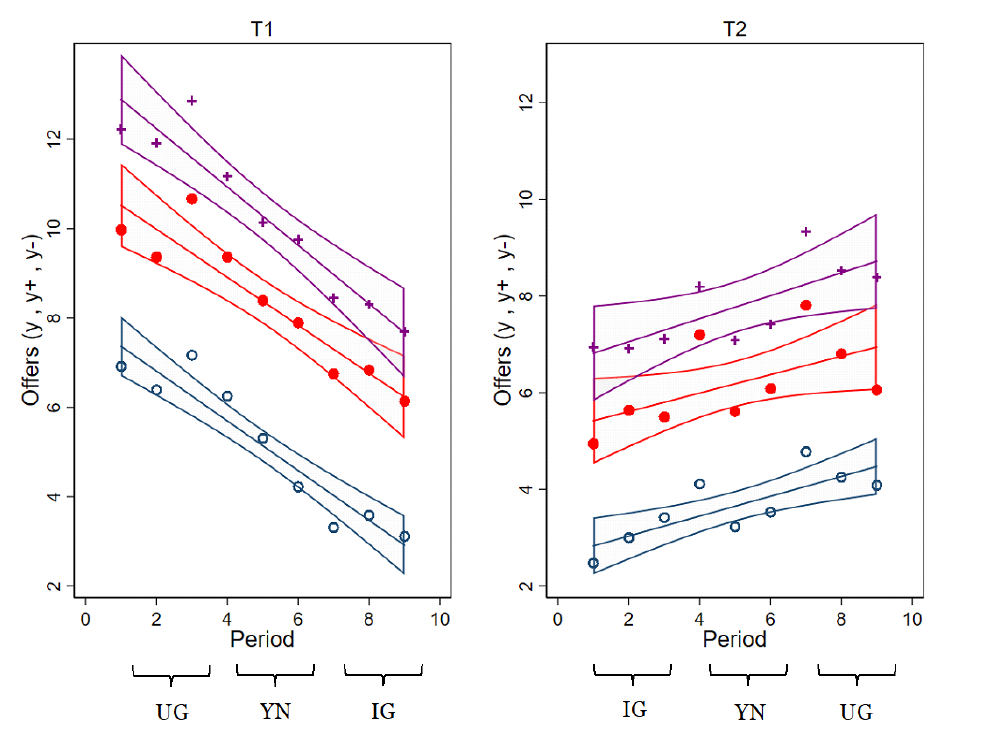
Figure 2. Independent offer and adjustments by treatment. Notes: Average values per period are indicated by + for y + , • for y , and ◦ for y − while lines represent linear prediction plots along with a confidence interval (CI